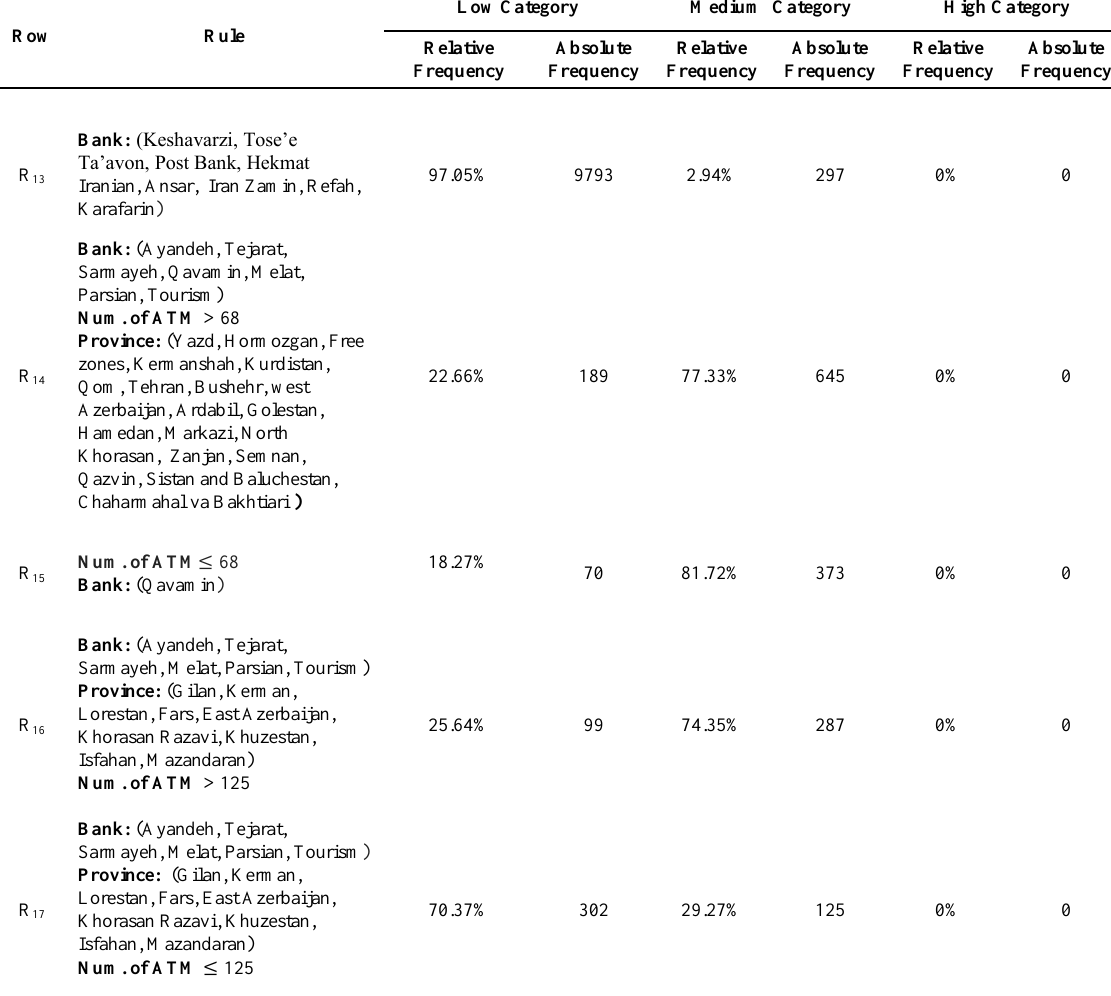
Table 13. Extracted rules of decision tree of Pin Pad transactions regardless of month and